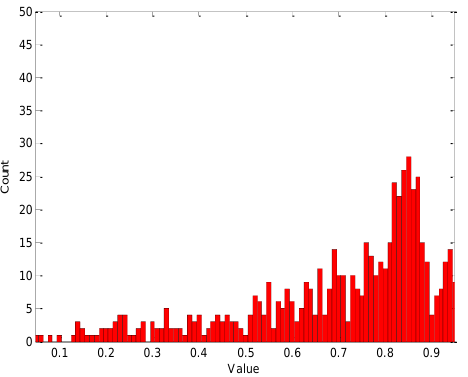
Fig.2 Histogram of vermilion abundance estimation based on derivative of ratio method (Sample